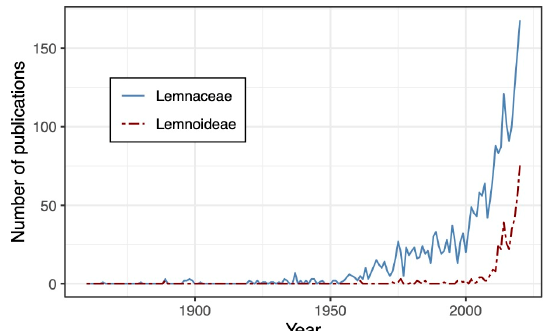
Figure 3. Usage of ‘Lemnaceae’ and ‘Lemnoideae’ in publications over time. Important events that may have influenced usage include the initial plastid data suggesting that duckweeds belong to the Araceae clade in 1995 [3] and the APG recommendation to include duckweeds in Araceae s.l., in 1998 [10]. Data were obtained from the Dimensions website (https://app.dimensions.ai/; accessed on 20 August 2021) by searching for each keyword anywhere in an